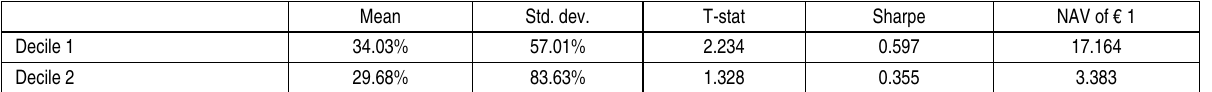
Table 2a. Performance statistics on accrual portfolios of traditional accruals Mean Decile